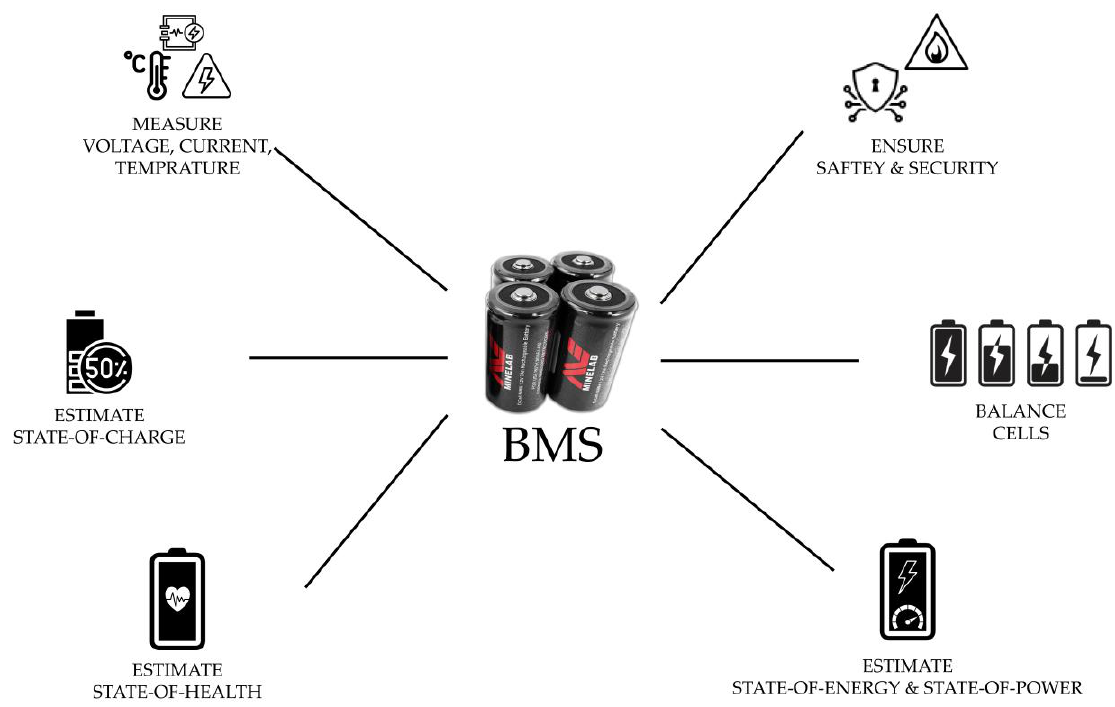
Figure 15. The principle of BMS.